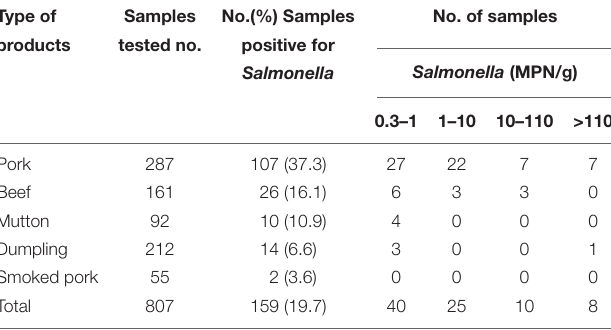
TABLE 1 | Prevalence and microbial load of Salmonella in retail meat and meat products from China. Type of